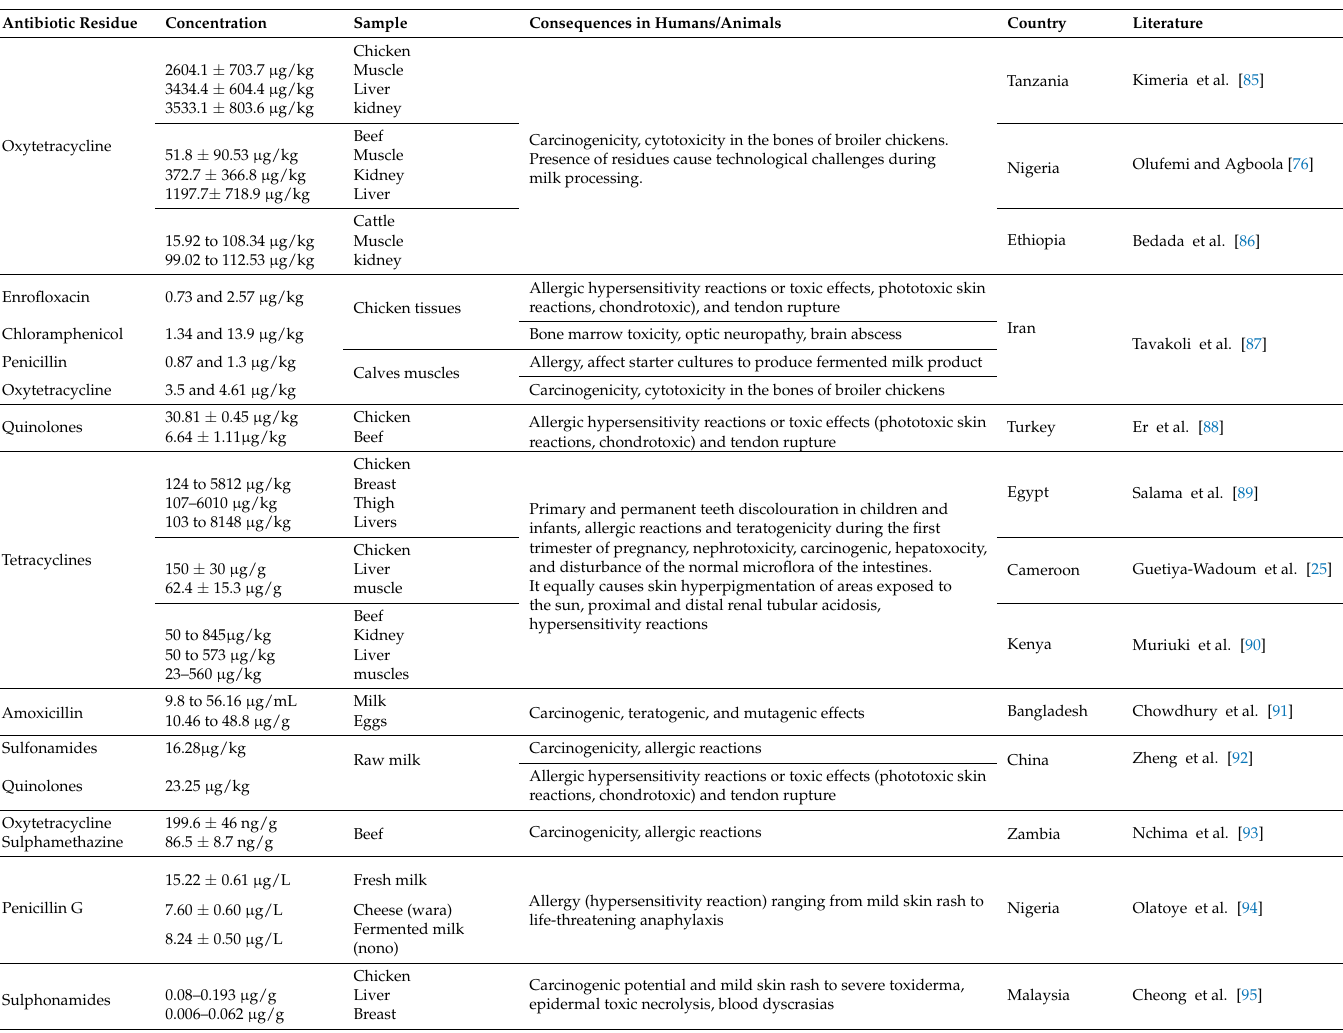
Table 1. Presence of varying concentrations of antibiotic residues in the different animal-derived products in some developing